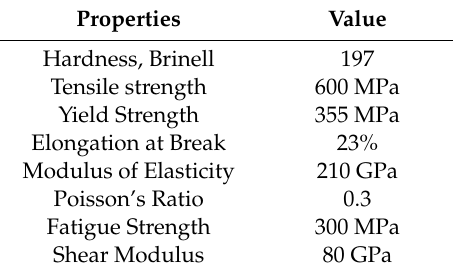
Table 4. C 45 steel